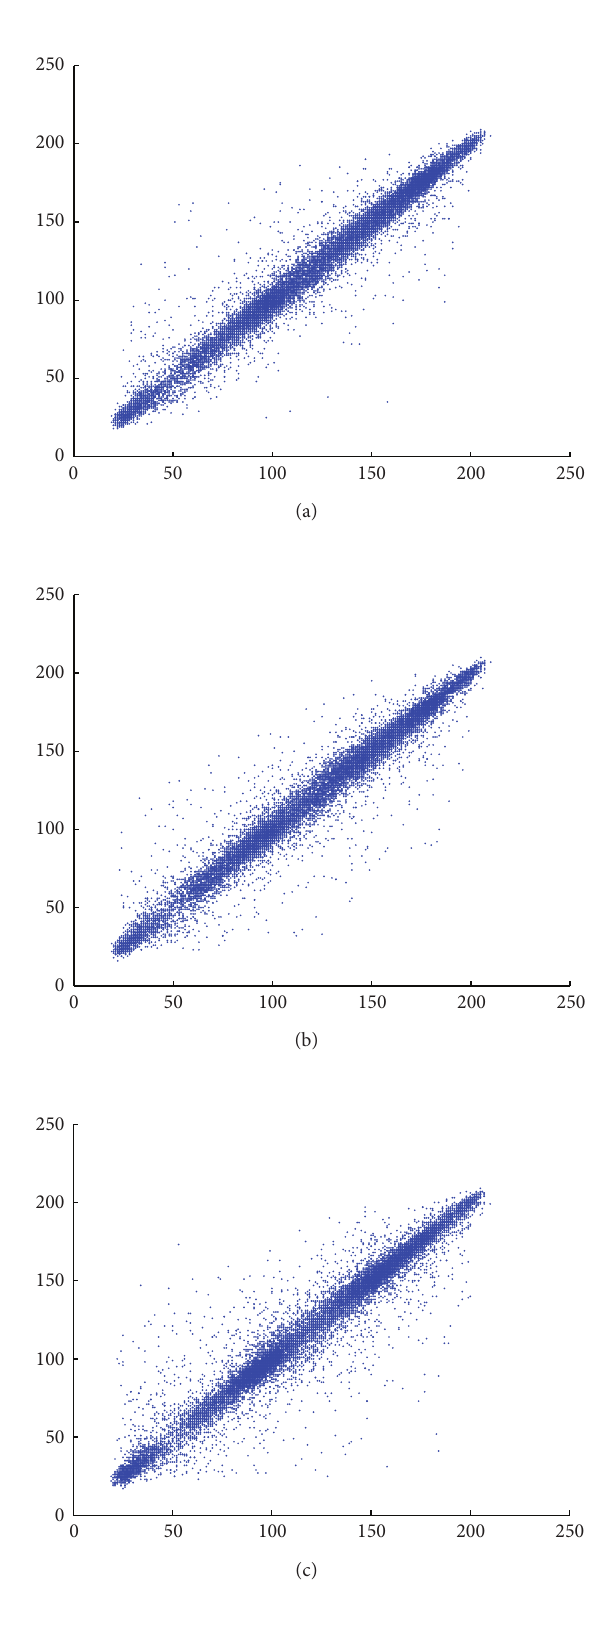
Figure 10: Correlation of plain image’s pixels in (a) horizontal, (b) vertical, and (c) diagonal